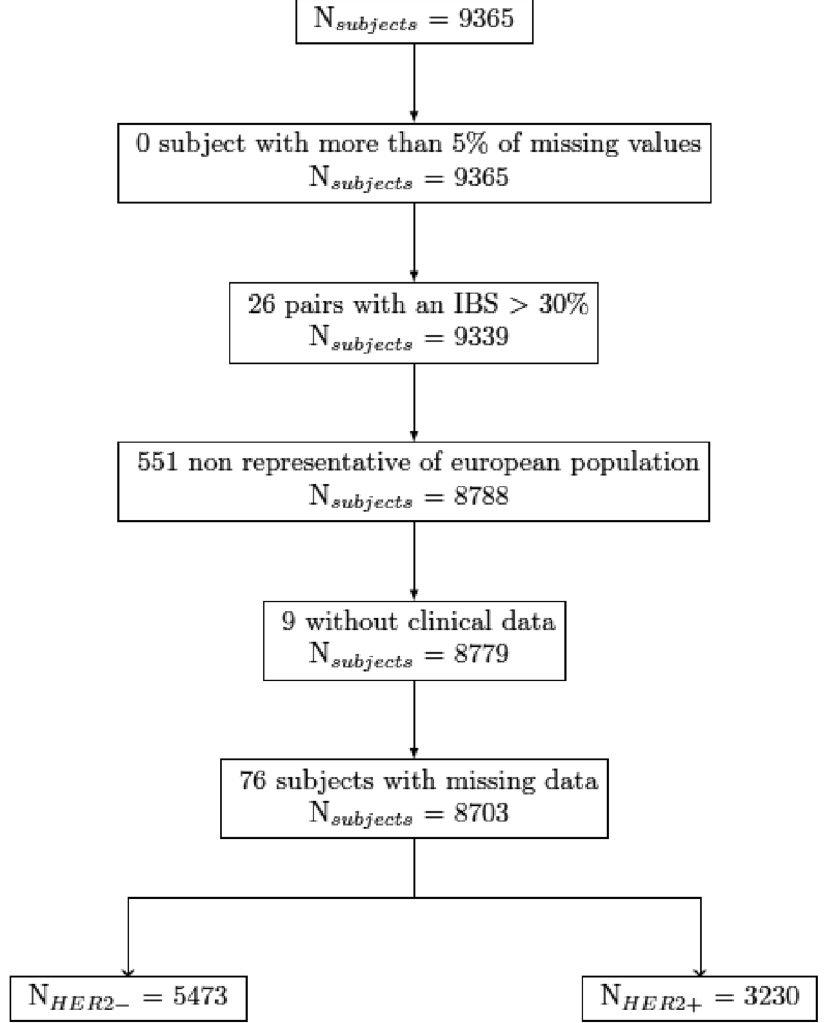
Fig. 1 Subjects retained for analyses based on